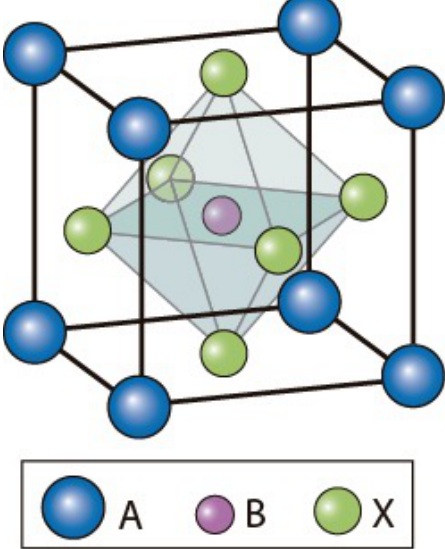
Figure 2. ABX crystalline structure